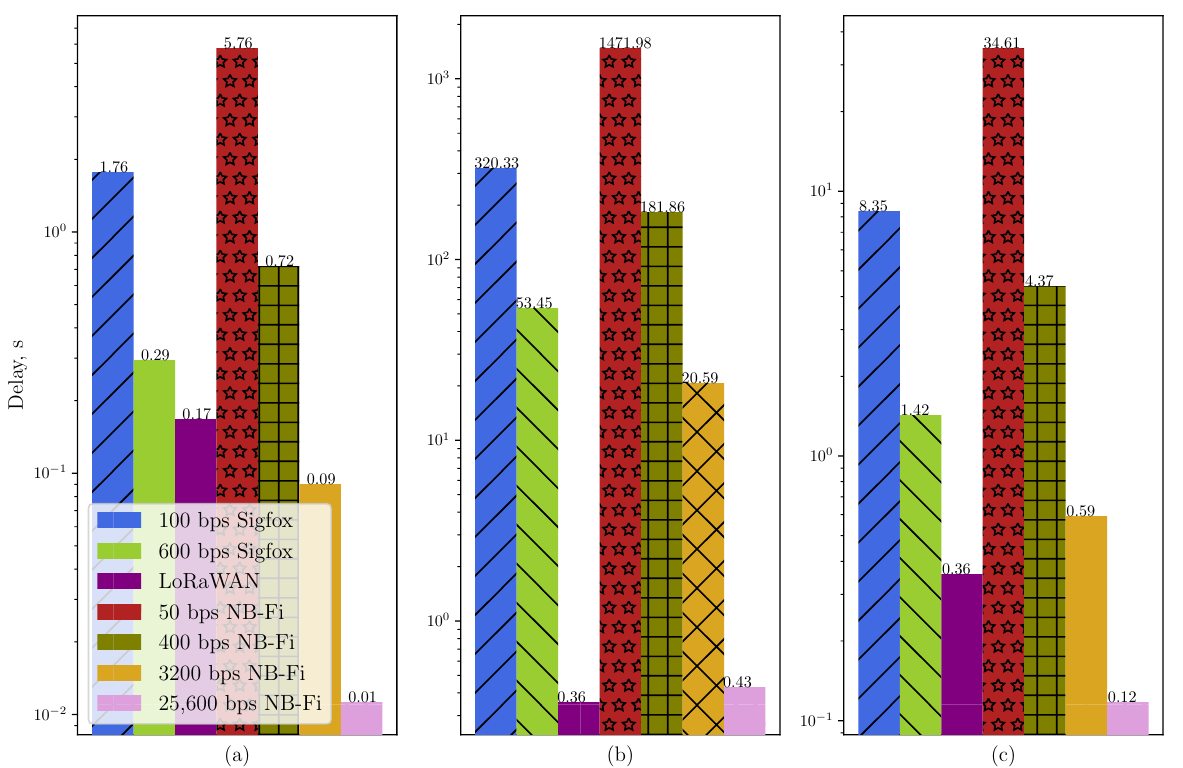
Figure 13. The average delay in ( a ) the unreliable transmission of short packets scenario; ( b ) the unre- liable transmission of long packets scenario ( T start = 10ms, T end = 100 transmission of long packets scenario ( T start = T end =